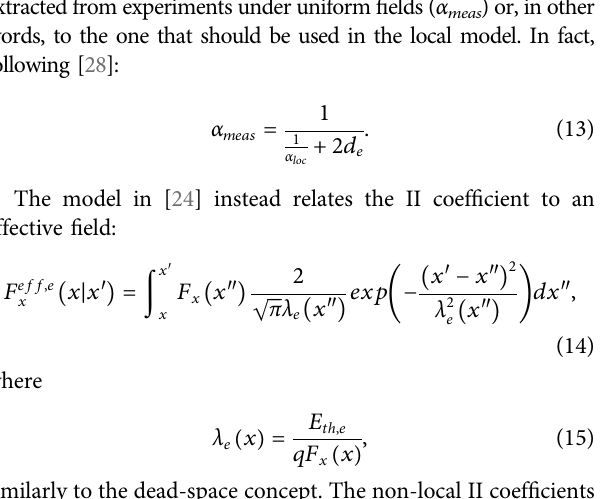
Frontiers in Physics |